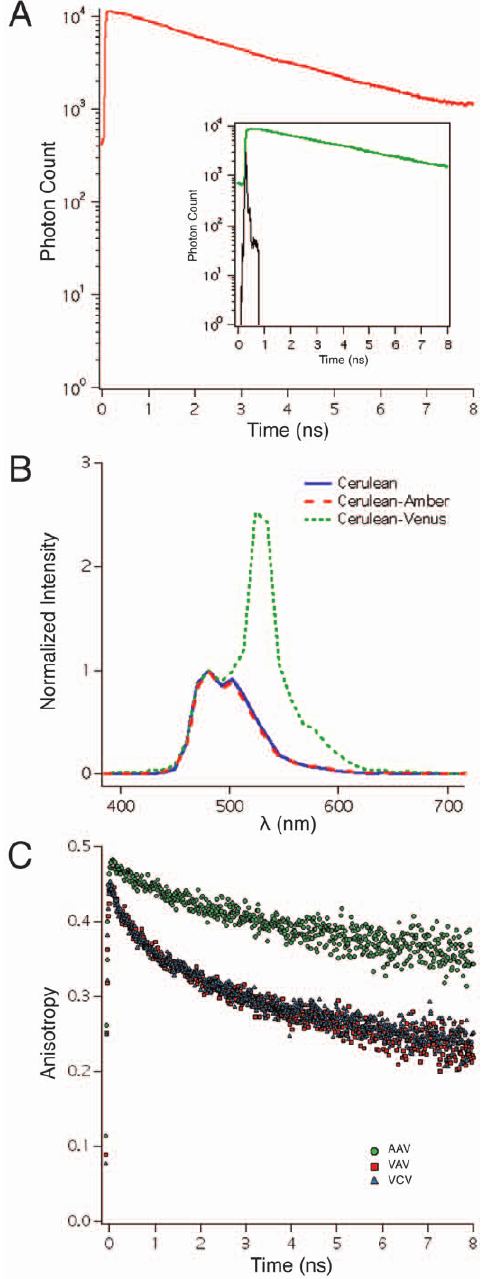
Figure 1. The Lifetime of Cerulean when flanked by two Amber molecules. A. The fluorescence lifetime of Cerulean in the ACA construct was measured by time-correlated single photon counting (RED trace is the mean of traces observed in 5 different cells expressing ACA). Fluorescein at pH 10 was used as a lifetime standard to validate the accuracy of our instrumentation and its fluorescence lifetime decay is depicted in the inset (GREEN trace, mean of 3 measurements). The instrument response function of our FLIM system is also depicted in the inset (BLACK trace). B. The normalized emission spectrum of cells transfected with either Cerulean (BLUE trace), Cerulean attached to Amber (RED dashed trace), or Cerulean attached to Venus (GREEN dotted trace). Each trace is the average of 3 cells, and all samples were excited with two-photon excitation at 820 nm. Traces were normalized to the peak of the Cerulean emission at 481 nm. C. The time resolved fluorescence anisotropy decay of Venus in cells transfected with AAV (GREEN circles), VAV (RED squares), or VCV (BLUE triangles). Each point is the mean of 10 cells excited at 950